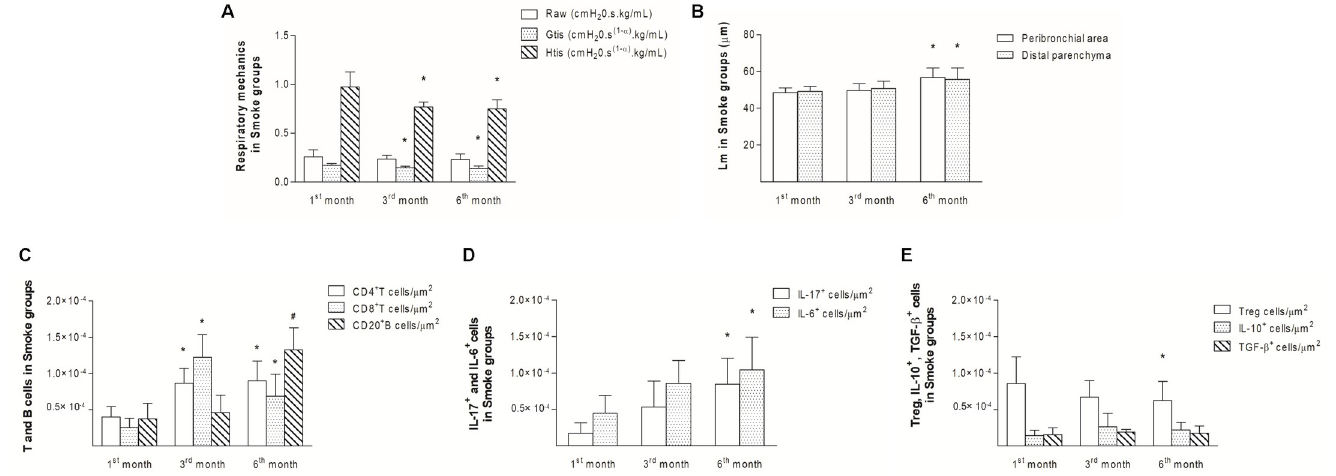
Fig 12. Temporal analysis of the Smoke groups. The respiratory mechanics (A), Lm values (B), T and B cells (C), IL-17 + or IL-6 + cells (D), Treg, IL-10 + or TGF- β + cells (E) in peribronchovascular areas in the Smoke groups after 1, 3, and 6 months are presented as the means ± SDs. (A) The Gtis ( � P = 0.0014, One-way ANOVA and Tukey’s post-test) and Htis ( � P = 0.0004, One-way ANOVA and Tukey’s post-test) after 3 and 6 months were significantly different from those found after 1 month. (B) The Lm values in the peribronchial area ( � P = 0.0019, Kruskal-Wallis test and Dunn’s post-test) and distal parenchyma ( � P = 0.0202, Kruskal-Wallis test and Dunn’s post-test) after 6 months were significantly different from those found after 1 month. (C) The numbers of CD4 + T cells ( � P = 0.0003, One-way ANOVA and Tukey’s post-test) and CD8 + T cells ( � P < 0.0001, Kruskal-Wallis test and Dunn’s post-test) after 3 and 6 months were significantly different from those found after 1 month. The numbers of CD20 + B cells ( # P < 0.0001, One-way ANOVA and Tukey’s post-test) after 6 months were significantly different from those found after 1 and 3 months. (D) The numbers of IL-17 + ( � P = 0.0004, One-way ANOVA and Tukey’s post-test) and IL-6 + cells ( � P = 0.0307, One-way ANOVA and Tukey’s post- test) after 6 months were significantly different from those found after 1 month. (E) The numbers of Treg cells ( � P = 0.0004, One-way ANOVA and Tukey’s post-test) after 6 months were significantly different from those found after 1 month.